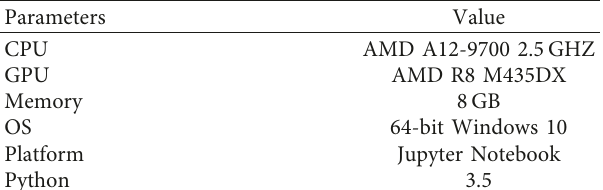
Figure 5: Relationship curves of accuracy rate with D. Table 4: Experimental